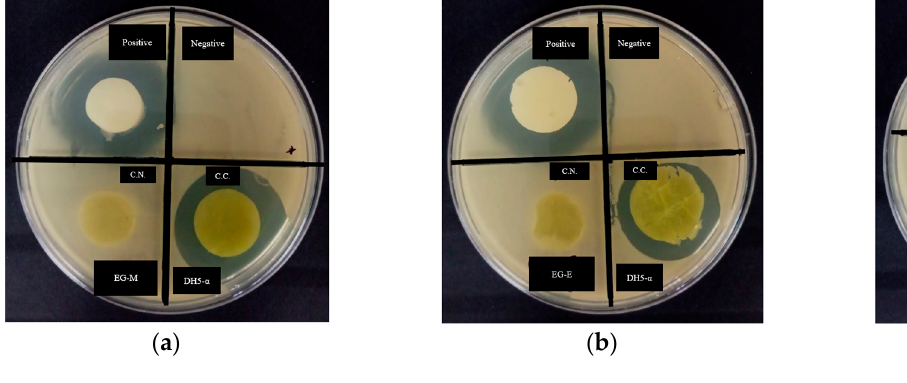
Table 7. Antibacterial activity of extract-loaded hydrogel against E. coli DH5- α growth. Diameter (cm) Plant Extract /NRC /MCC Positive Control EG-methanolic NA EG-ethanolic NA Without extract NA NA 3.52 Legend: NA =